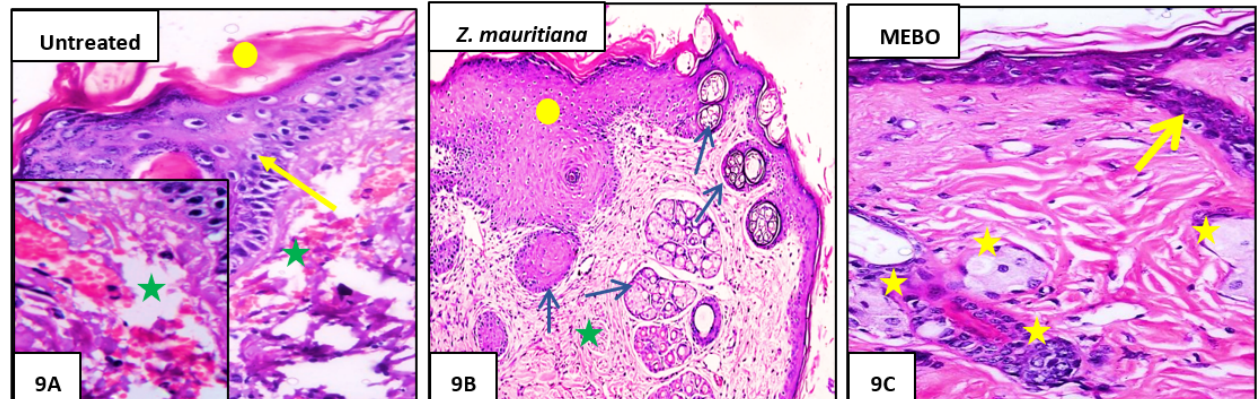
Figure 9. Histograms of wounded skin 14 days after incision: ( A ) of Group 1 (untreated) showing the wide wound area (yello circle), heavy inflammatory cellular infiltration in an acidophilic matrix (green star), and the normal skin (yellow arrow). ( B ) of Group 2 ( Z. mauritiana fruits extract) showing the typical stratified squamous keratinized epithelium (yellow circle), dermal matrix with coarse wavy collagen bundles in different directions (green star), and numerous newly formed hair follicles (blue arrows). ( C ) of Group 3 (MEBO ® -treated) showing typical epithelium with thin scar tissue extending into the dermis (yellow arrow), reticular dermis has coarse wavy collagen bundles arranged in different directions, and newly formed hair follicles (yellow stars). (Hematoxylin and eosin stain × 200 and 400).